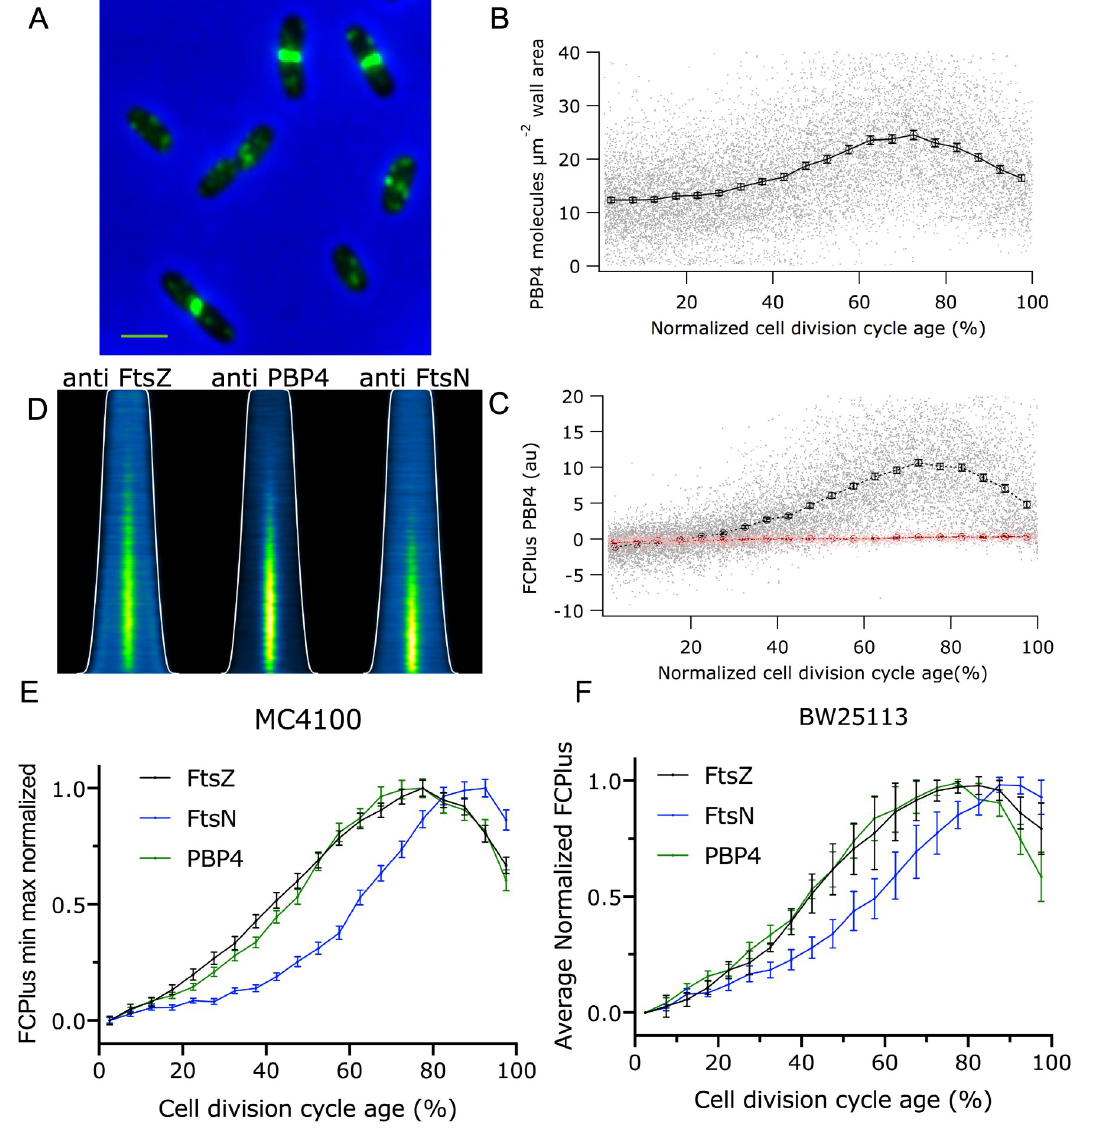
Fig 2. Cell division cycle timing of the localization of PBP4. ( A) MC4100 cells were grown to steady state in minimal glucose medium at 28˚C and immunolabeled with antibodies specific for PBP4. An overlay of a phase contrast and its corresponding fluorescence image is shown. Scale bar equals 2 μ m. (B) The potential number of PBP4 molecules in the cell wall area (see results section), calculated from the volume of the cells is plotted as function of the cell division cycle age. The dots are the values for the individual cells and the markers are 5% age bins with 95% confidence. (C) The extra fluorescence at midcell compared to the rest of the cell (FCPlus) is plotted as function of the normalized cell division cycle age. The dots (grey for MC4100 and light pink for the BW25113 Δ dacB strain) are the values measured for the individual cells and the markers with bars (black for the wild-type MC4100, red for the BW25113 Δ dacB ) are 5% age bins with 95% confidence. (D) Demographs of the localization of FtsZ, PBP4 and FtsN in the cells sorted according to cell length. The white line indicates the length of the cells. (E) Comparison of the timing of the localization at midcell of FtsZ (black), PBP4 (green) and FtsN (blue) during the cell division cycle age. The FCPlus values are min-max normalized to enable timescale comparison, despite differences in molecule number and antibody affinities. (F) BW25113 wild-type cells were grown to “steady state” in minimal glucose medium at 28˚C and immunolabeled with antibodies specific for FtsZ, PBP4 and FtsN. The FCPlus of three independent biological experiments in 5% age bins was determined. The binned FCPlus values were min-max normalized. The average min-max normalized FCPlus values of the three experiments were subsequently plotted as function of the cell division age cycle.